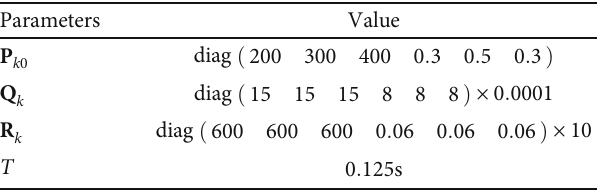
Table 4: EKF parameters.